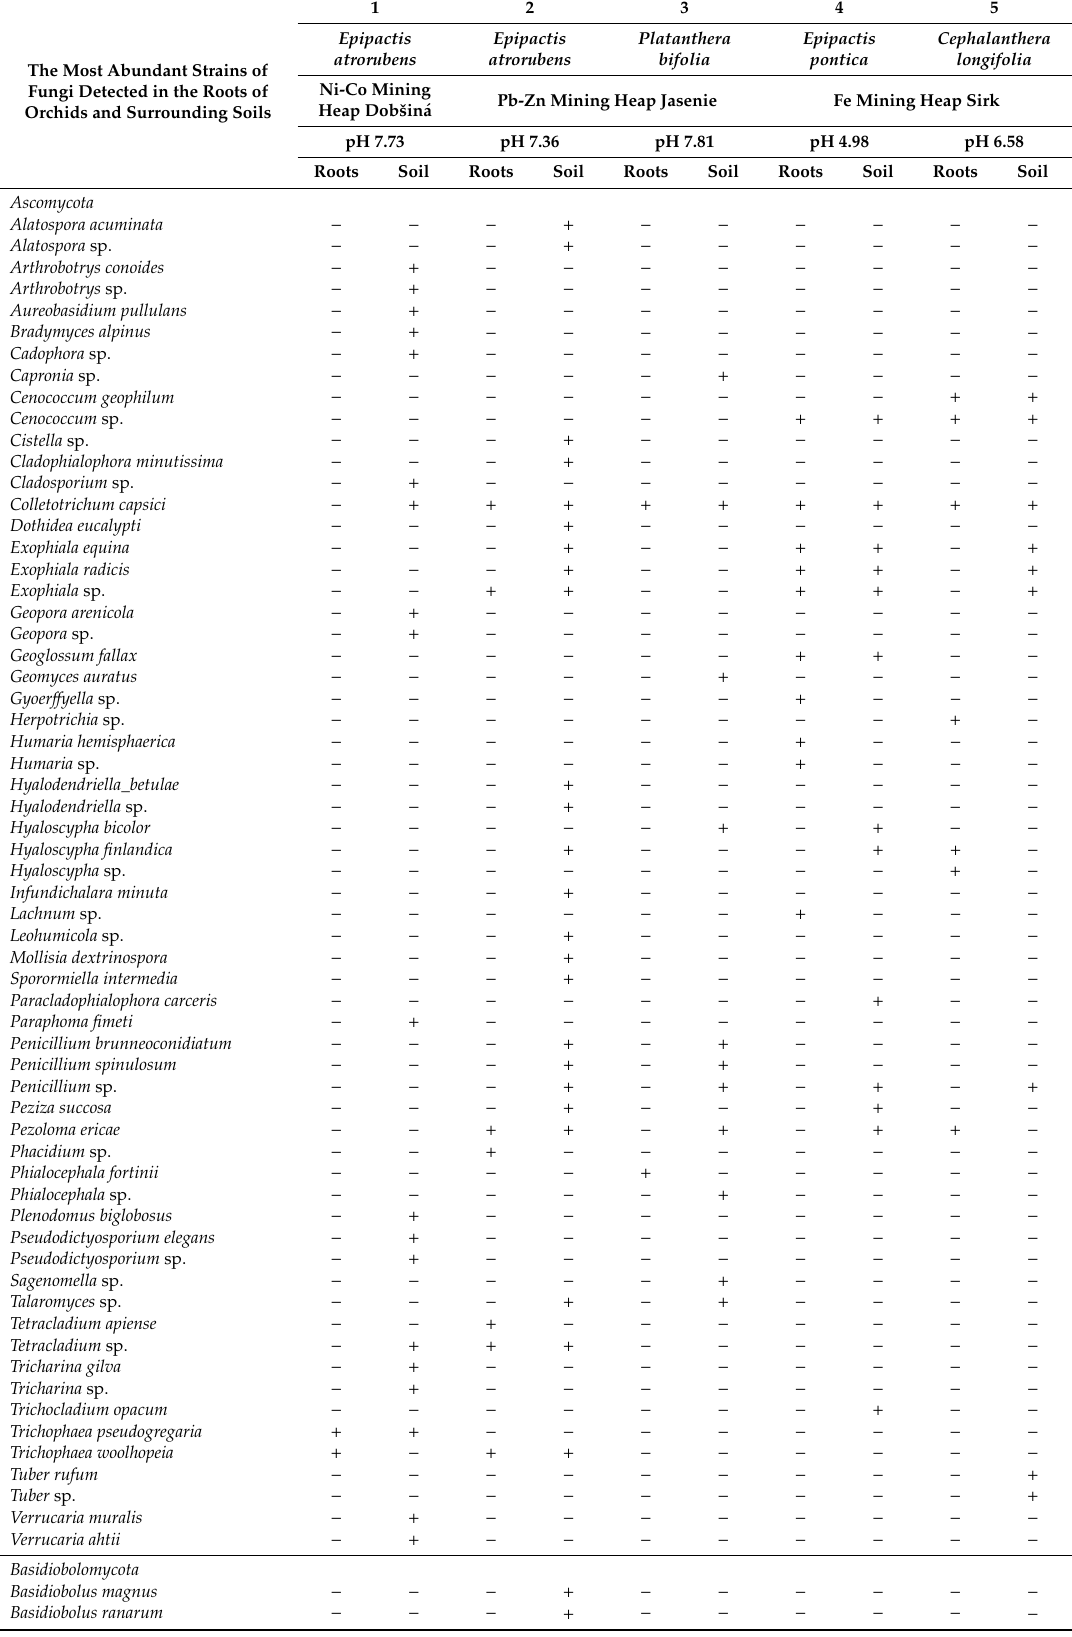
Table 1. DNA identification of the fungi isolated from the roots of the orchids and surrounding soils.